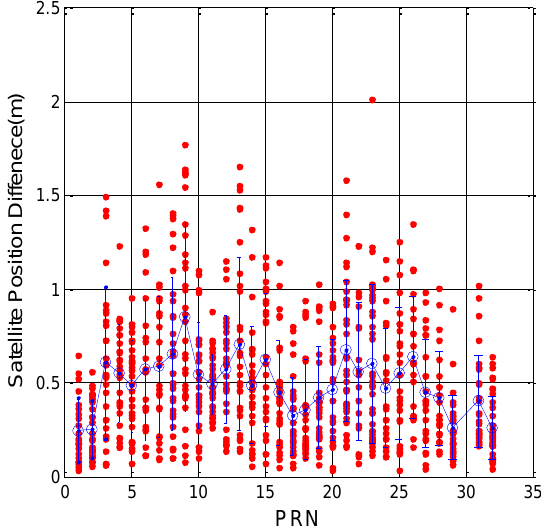
Figure 3. GPS DQA1: Satellite position differences between new and original ephemeris.